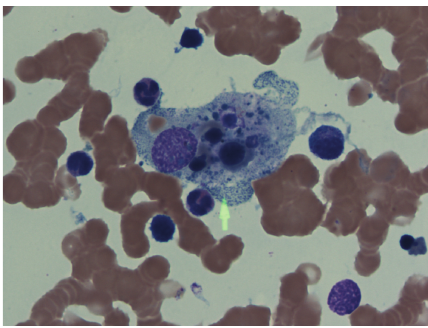
Figure1:Thehistiocyteinthecenterofthispictureappears“stuffed” with engulfed erythrocyte